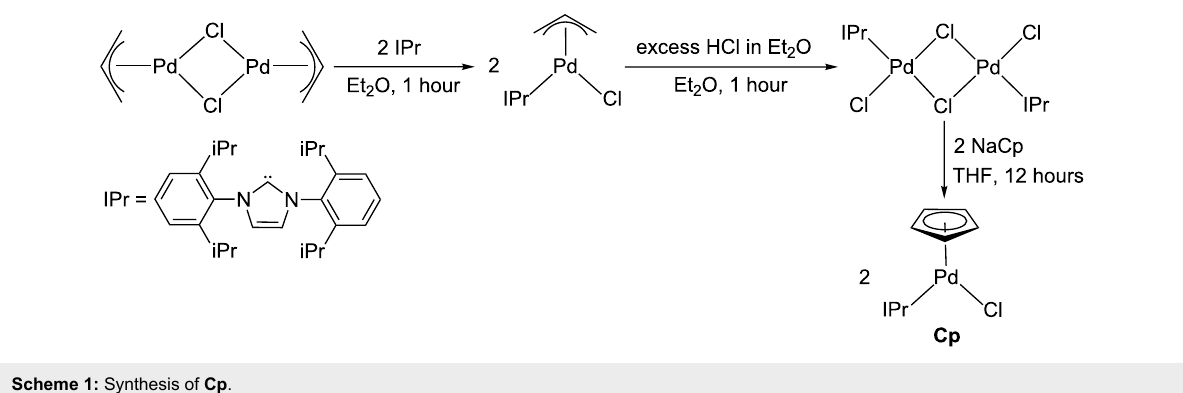
Scheme 1: Synthesis of Cp .